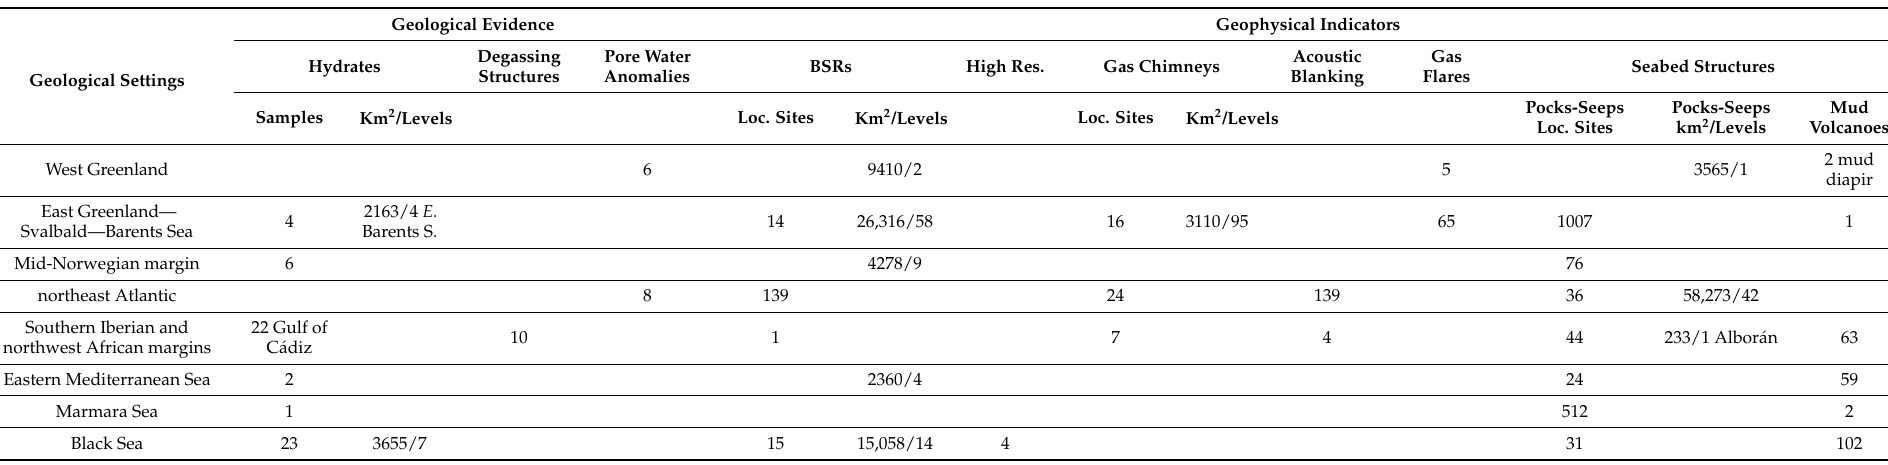
Table 2. Geological and geophysical evidence and indicators of marine gas hydrates stored in GARAH